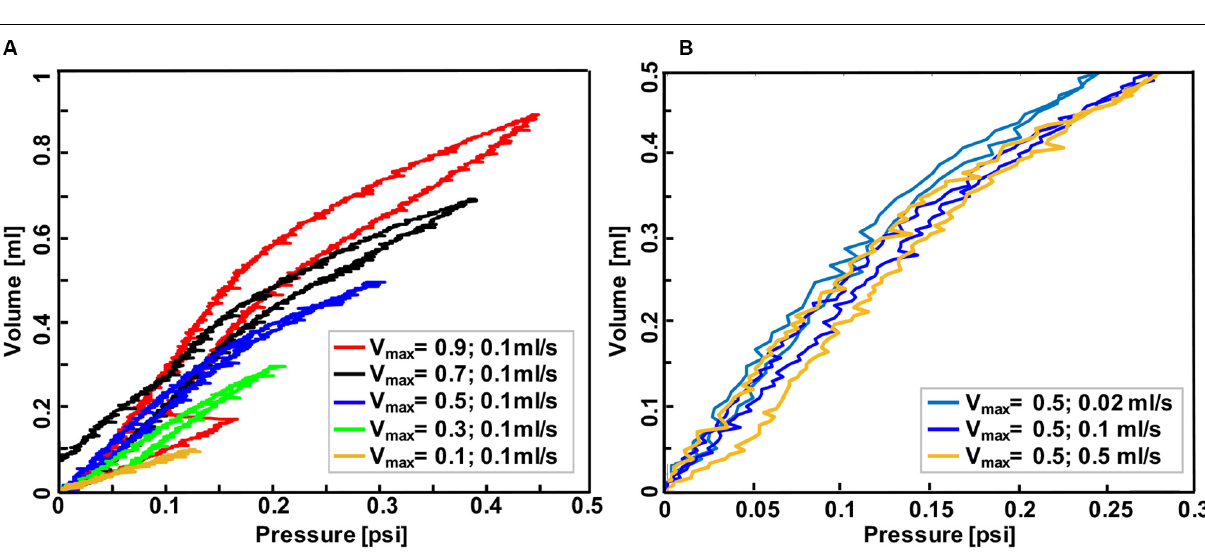
FIGURE 5 | Volume-pressure curve of the third inflation-deflation cycle in mouse #2 lung where the maximum volume ranged from 0.1 to 0.9 ml with a constant rate of 0.1 ml/s (A) and where the inflation volume was fixed at 0.5 ml and the inflation-deflation rate varied (B) . Less compliant behavior was found when the lung was inflated to smaller volumes at a fixed rate, and also when it was inflated faster to a specified